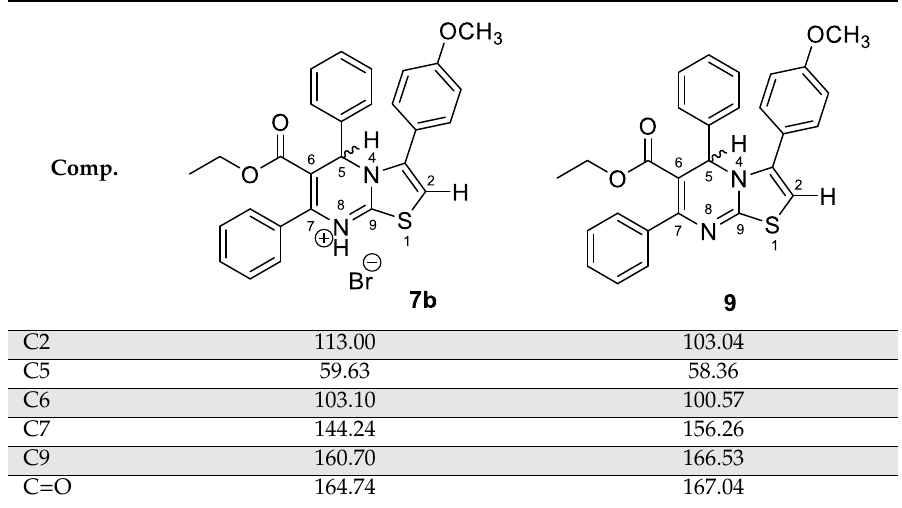
Table 2. Comparison of the relevant carbon chemical shifts (δ , in ppm) for the protonated compound 7b and the non-protonated compound 9.